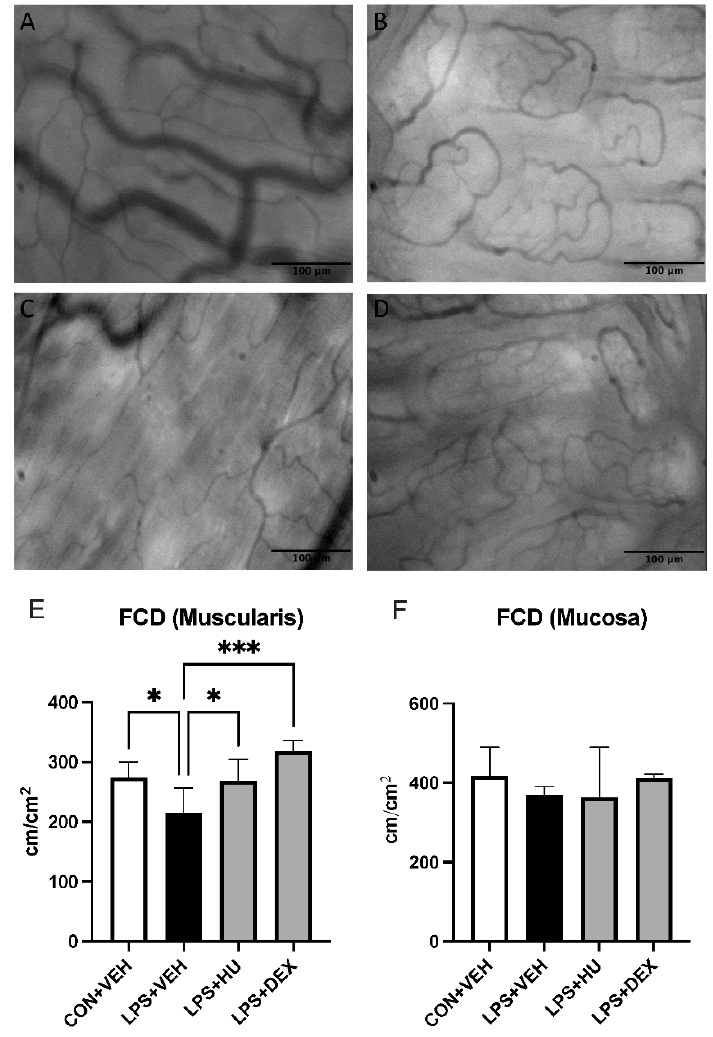
Figure 5. Impact of LPS and treatment on intestinal capillary perfusion. Representative images of ileal ( A ) muscularis and ( B ) mucosal capillaries in con + veh mice, and ( C , D ) LPS + veh mice. Analysis of FCD in ( E ) muscularis and ( F ) mucosal layers. Data are expressed as mean ± SD. Statistically significant differences were determined via one-way ANOVA with Dunnett’s multiple comparisons test and are depicted as * p ≤ 0.05, *** p ≤ 0.001.